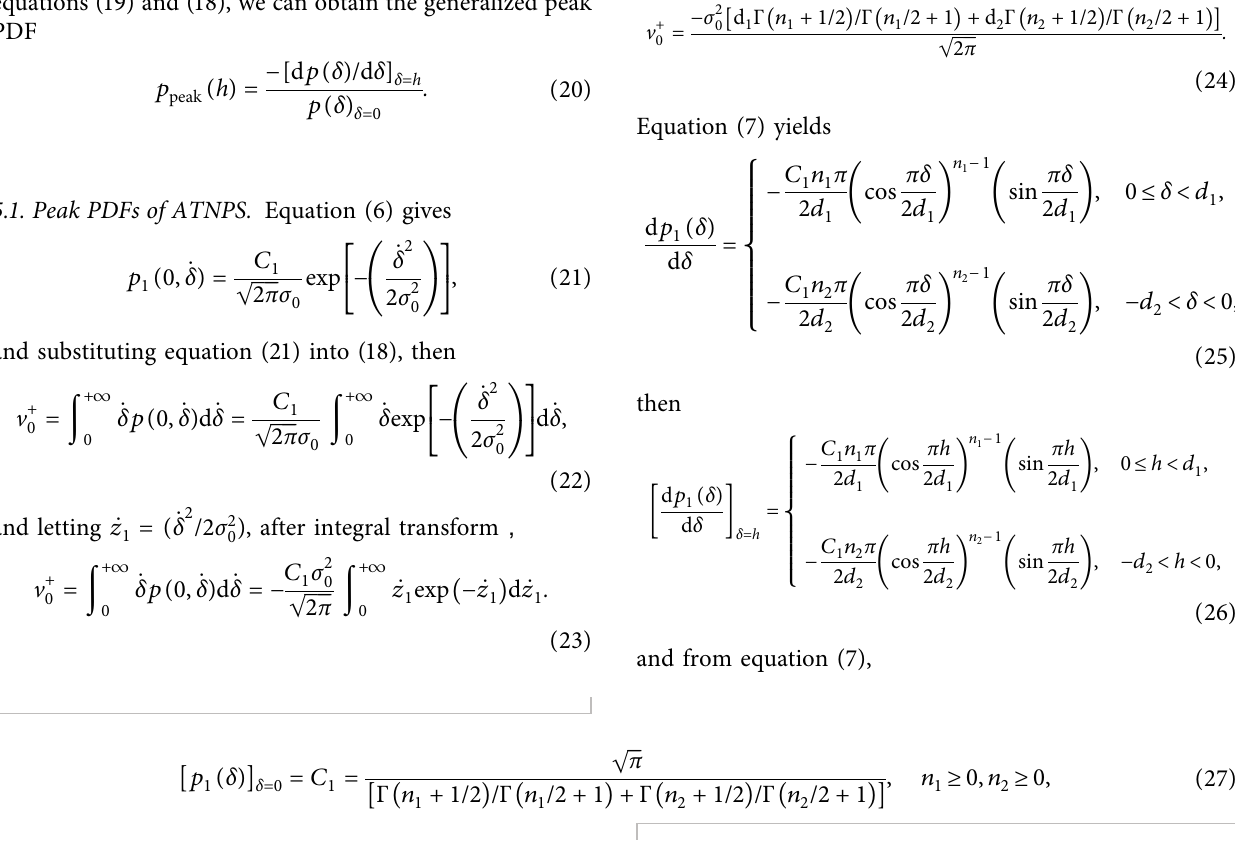
Figure 15: Displacement PDFs of ATHNPS for various values of σ 2 of Gaussian